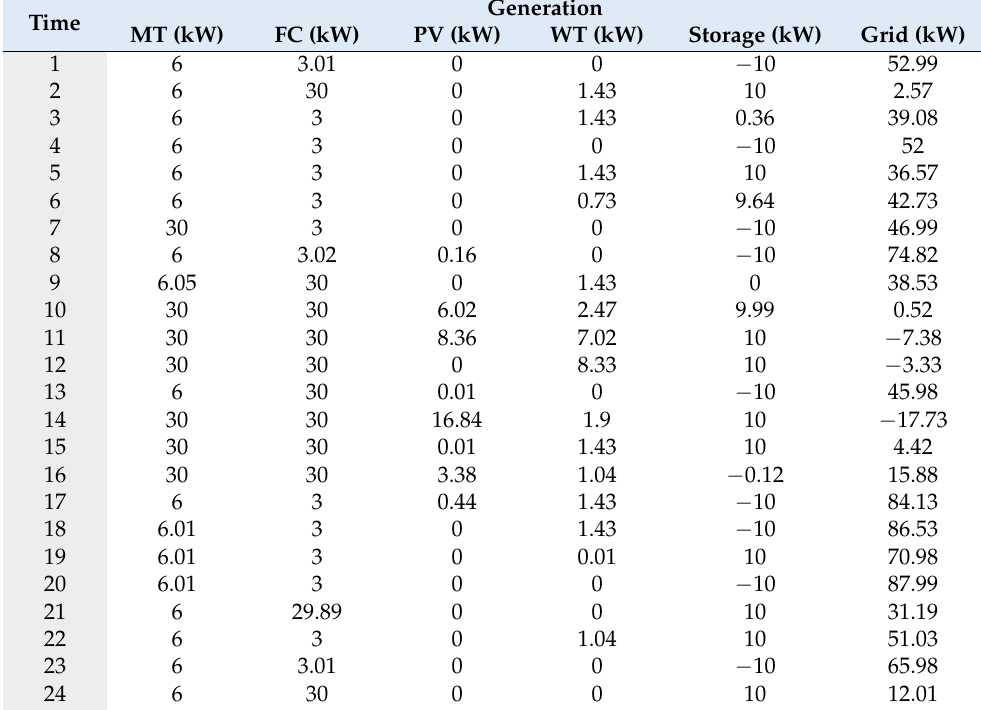
Figure 6. Comparing Pareto Fronts in different methods without considering the limits of upstream power exchange (cost and emission based). Table 13. Power distribution in a Pareto Front sample answer without considering the limits of upstream power